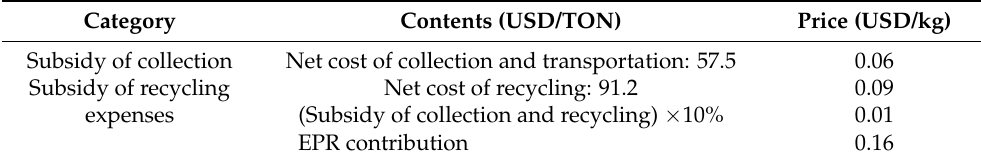
Table 2. Cost of introducing EPR for